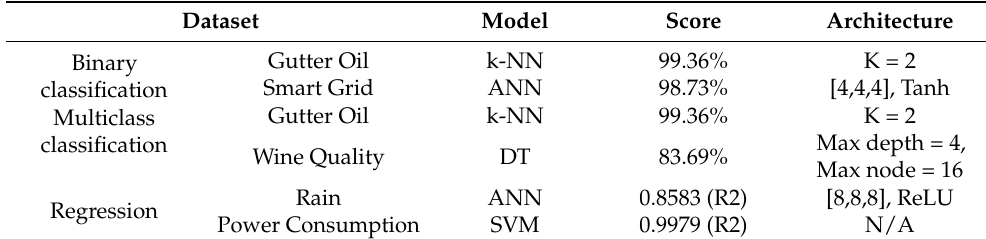
Figure 10. Comparison of the receiver operating characteristic curve and precision-recall curve for the six typical IoT endpoint datasets with different algorithms. ( a ) Receiver Operating Characteristic curve for Gutter Oil binary classification; ( b ) Receiver Operating Characteristic curve for Smart Grid binary classification; ( c ) Receiver Operating Characteristic curve for Gutter Oil multiclass classification; ( d ) Receiver Operating Characteristic curve for Smart Grid multiclass classification; ( e ) Precision-Recall curve for Gutter Oil binary classification; ( f ) Precision-Recall curve for Smart Grid binary classification; ( g ) Precision-Recall curve for Gutter Oil multiclass classification; ( h ) Precision- Recall curve for Smart Grid multiclass classification. Table 16. The highest-scoring model obtained in different